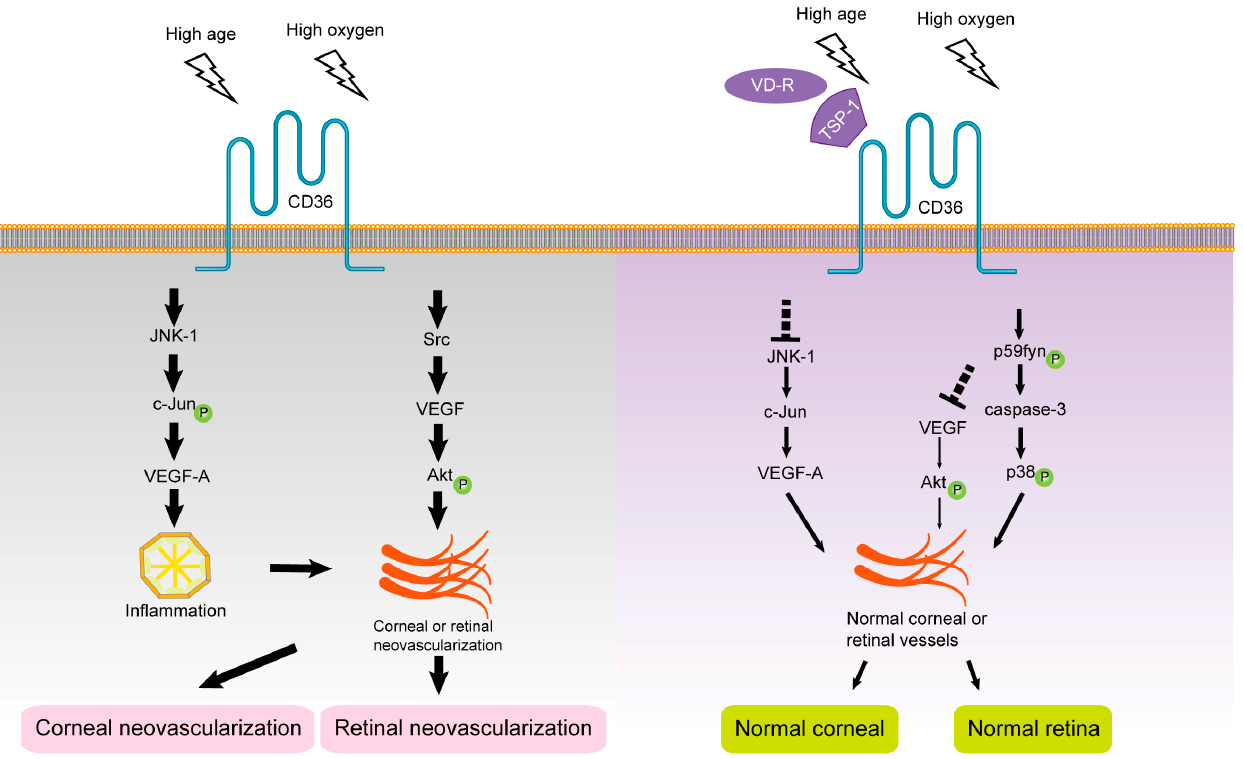
Figure 4. The roles of CD36 in intraocular neovascularization.